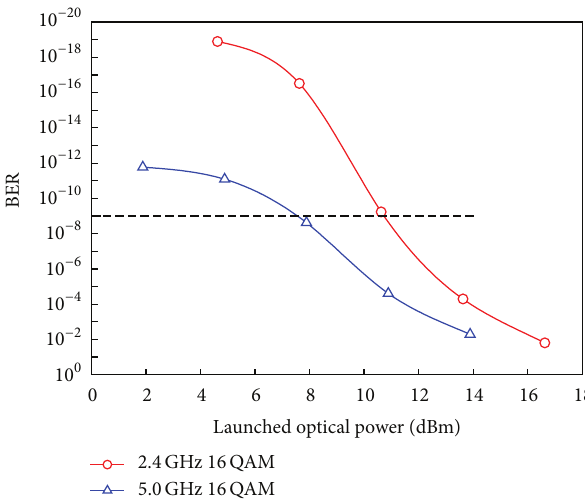
Figure 5: The fiber nonlinearity effect on the system performance.